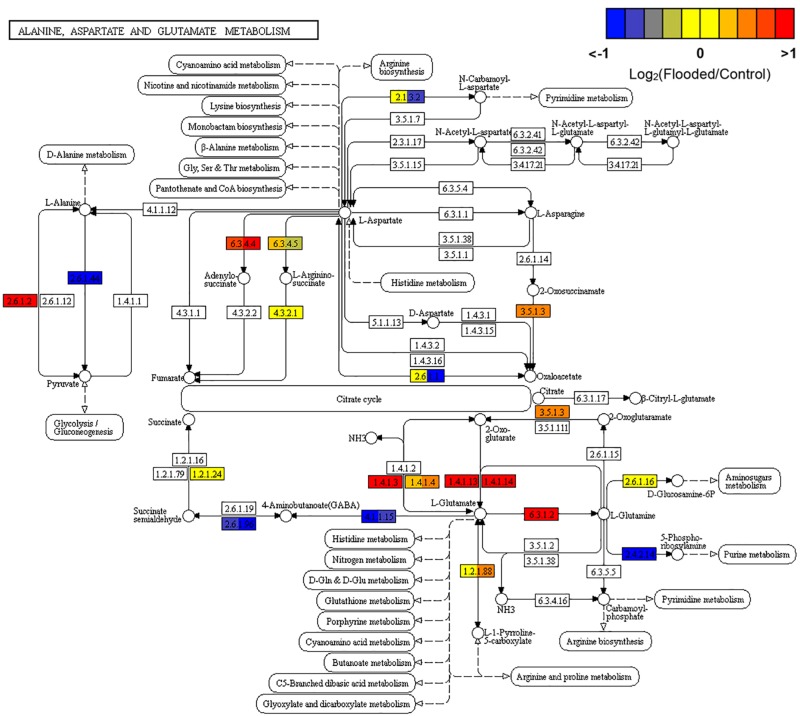
KEGG map of Alanine, Aspartate and Glutamate metabolism (map00250) pathway rendered by Pathview (Luo et al., 2017). Each box is divided in three sub-boxes and represents a specific enzymatic step with the relative expression of the corresponding genes in Flooded versus Control roots, calculated as log2-ratio at T1, T2, and T6 (from left to right).